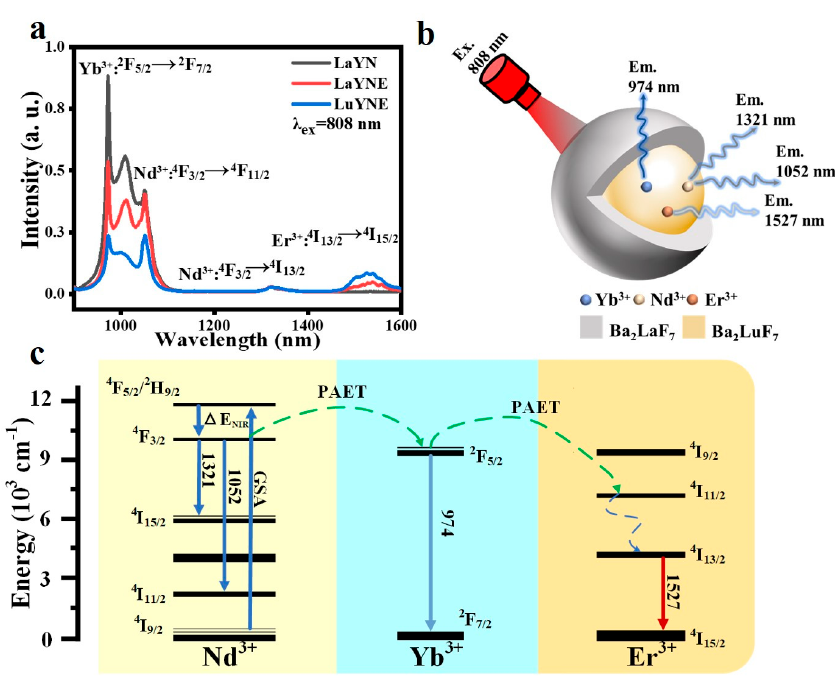
Figure 2. ( a ) The emission spectra of Yb 3+ /Nd 3+ and Yb 3+ /Er 3+ /Nd 3+ codoped Ba 2 LaF 7 and Ba 2 LuF 7 nanoparticles, and the excitation light source wavelength is 808 nm. ( b ) Schematic illustration of the luminescent nanoparticles excited by 808 nm laser. ( c ) General energy level diagram of Er 3+ , Yb 3+ , and Nd 3+ ions.